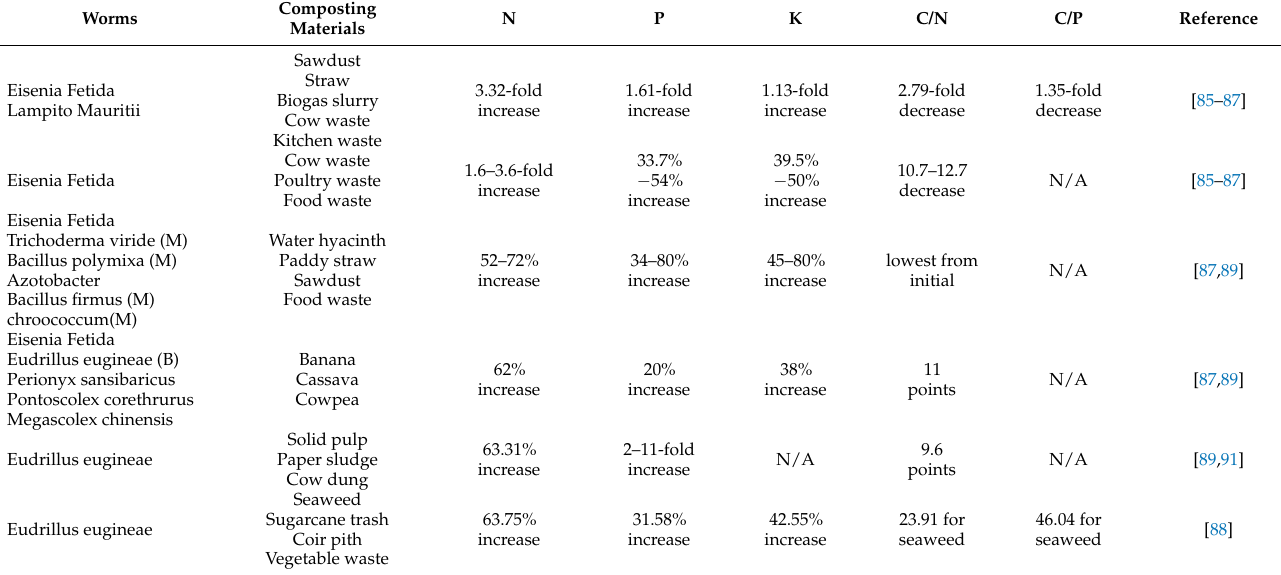
Table 4. Chemical properties of different worms in